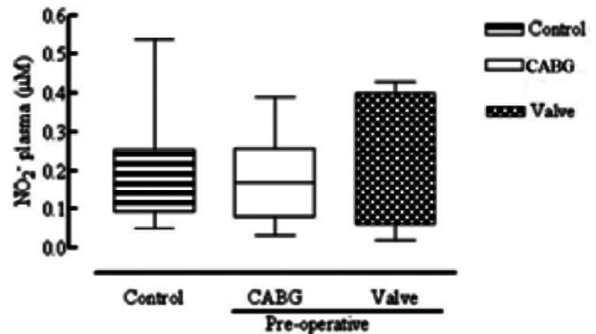
Fig. 4 - Concentrations of NO 2- plasma comparing the three groups (control group, preoperative myocardial revascularization and preoperative valve